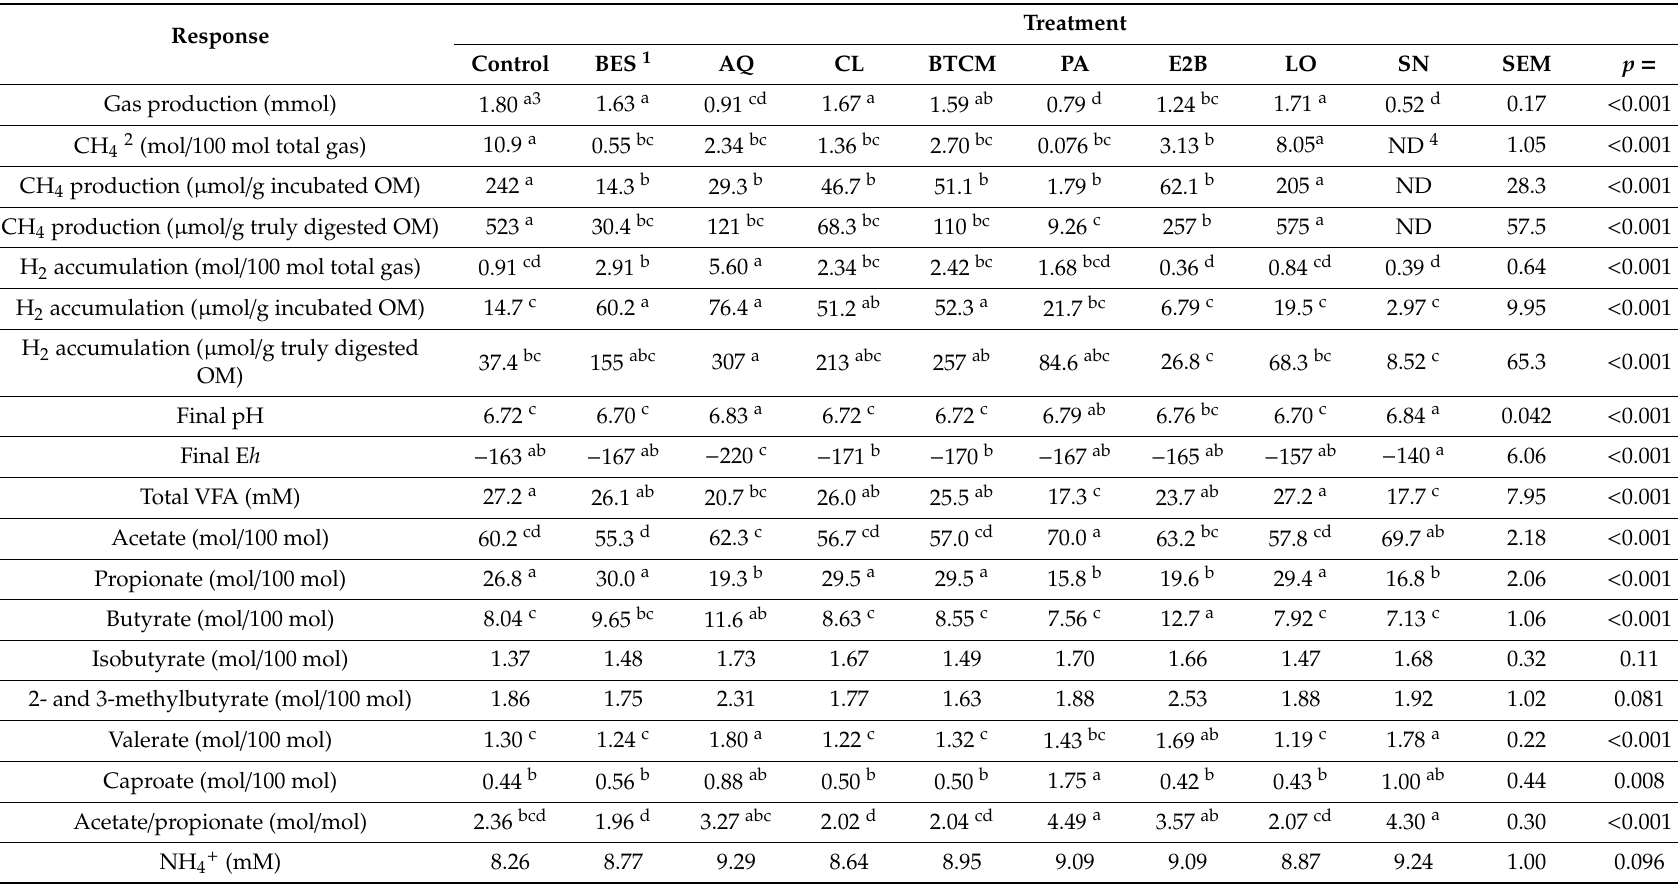
Table 1. E ff ects of several inhibitors of methanogenesis on fermentation of rumen mixed batch cultures.